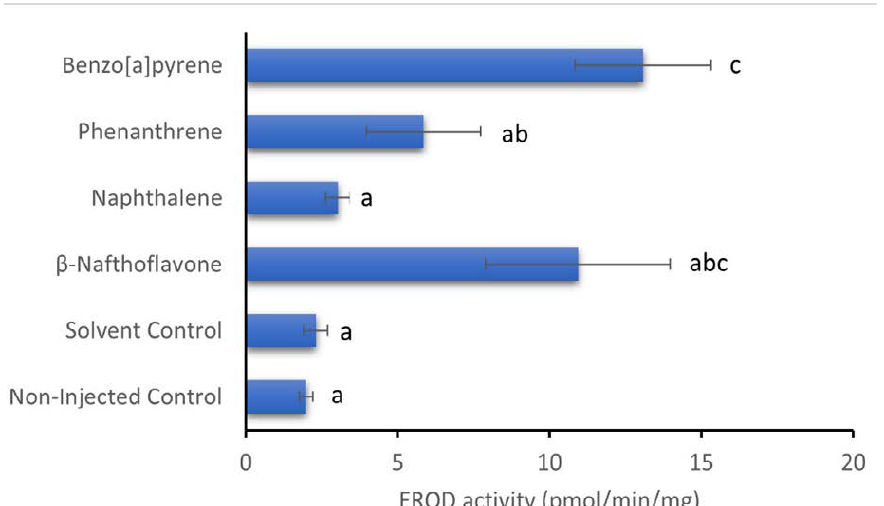
Fig. 3: Hepatic EROD activity in livers of Aequidens metae exposed to PAH during 72 h. Bars shown the mean ± SE (n = 5). abc Bars with different letters shown statistically significant differences (Tukey-Test, p<0.05)